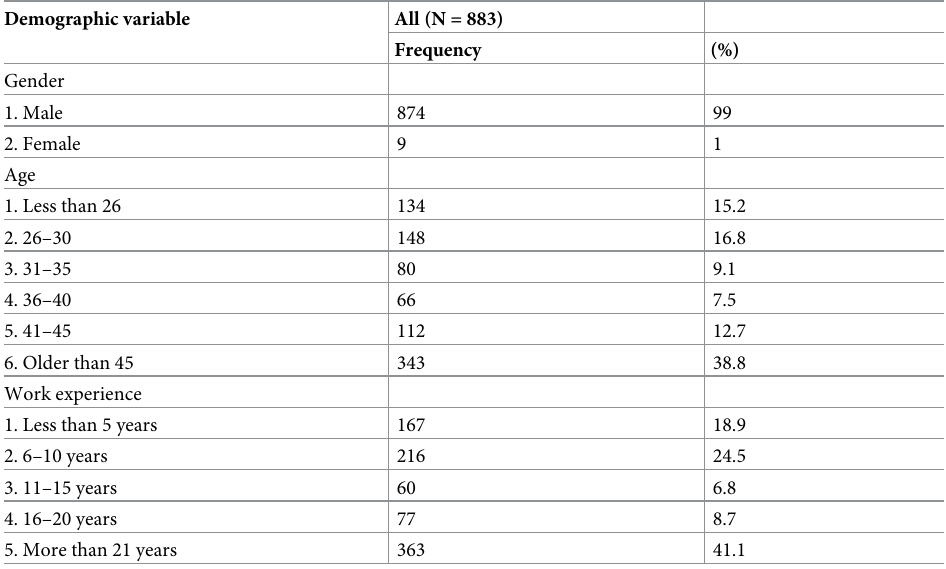
Table 2. Profile of